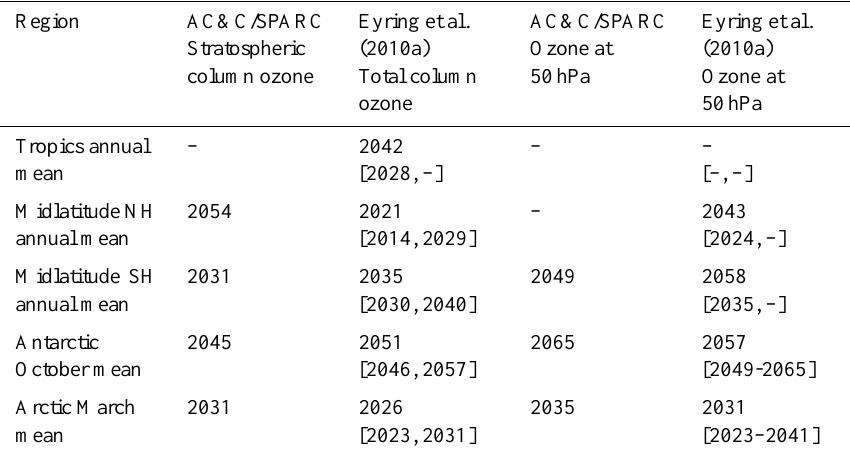
Table 3. Date of return to 1980 column and 50hPa ozone in the AC&C/SPARC ozone database compared to the 1980 baseline-adjusted time series of Eyring et al. (2010a). The range in brackets in the right most columns provides the uncertainty range from the 18 CCMs in Eyring et al. (2010a). For the AC&C ozone database, the stratospheric ozone is shown since tropospheric column ozone differs substantially among the RCP scenarios (see Eyring et al.,